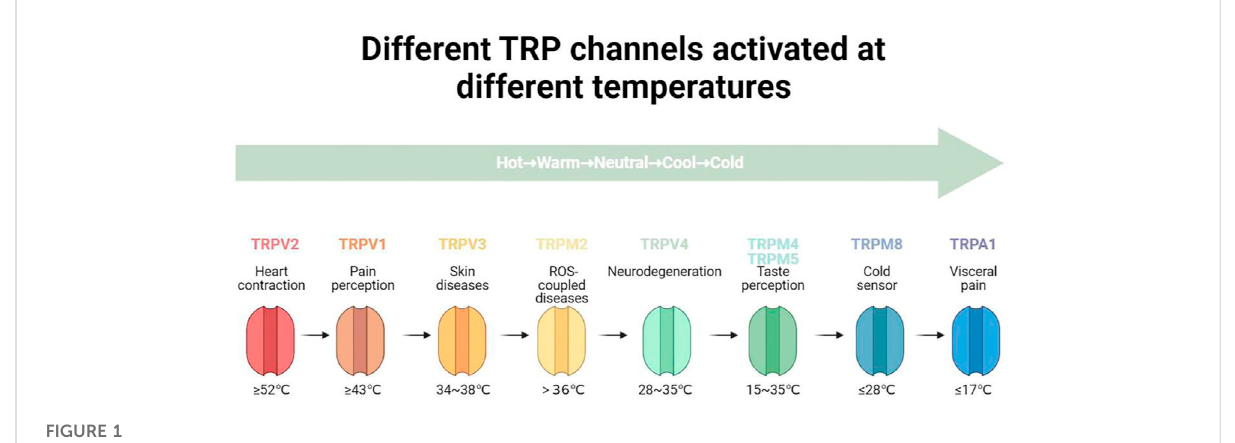
FIGURE 1 Different TRP channels activated at different